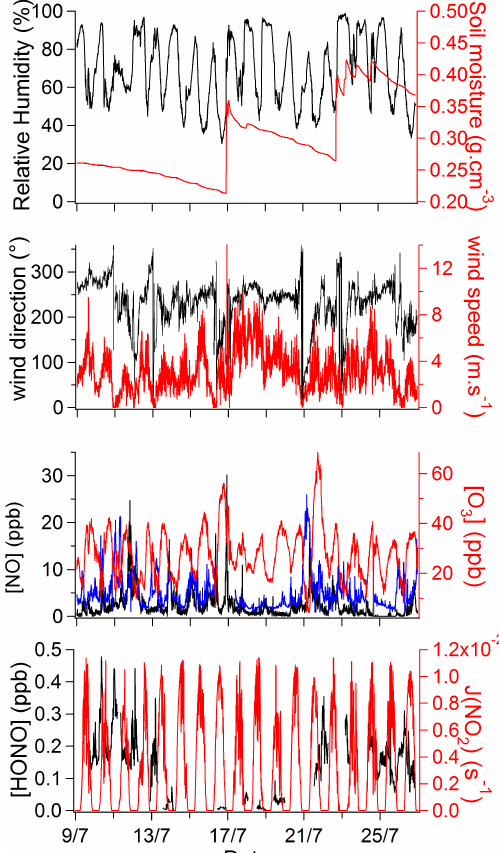
Fig. 1. 10min averaged data of relative humidity, soil moisture mea- sured at 5cm below ground level, wind direction, wind speed, NO x , O 3 , HONO and J (NO 2 ) during the MEGAPOLI summer field cam- paign at the SIRTA observatory, 9–26 July